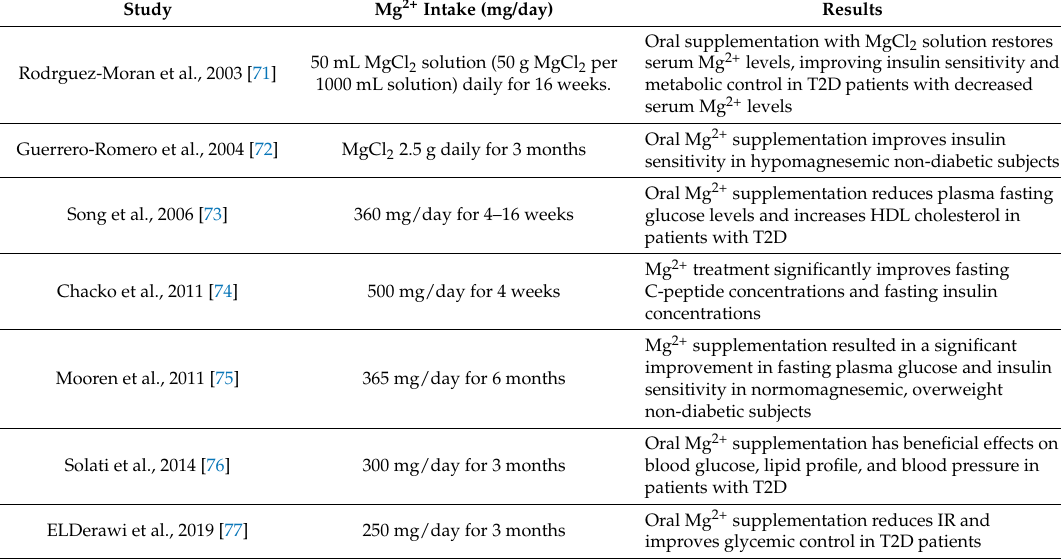
Table 2. The benefits of Mg 2+ supplementation for improvement of insulin sensitivity in patients with T2D and overweight non-diabetic